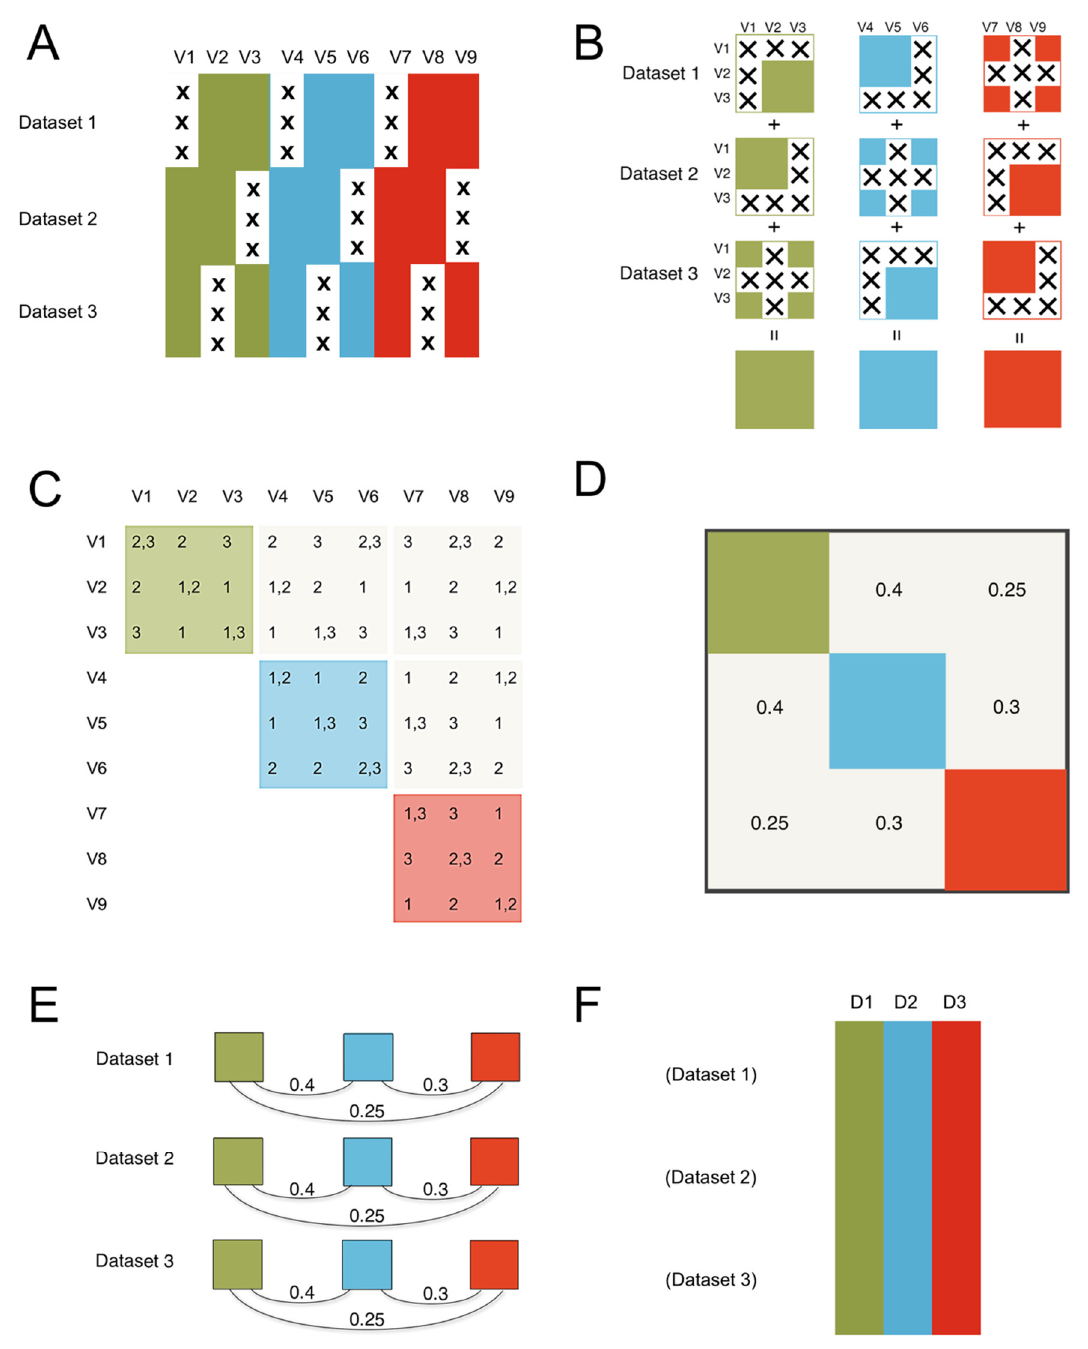
Figure 1. The ROSETTA flow of information. The method consists of three steps to get from the constituent datasets that are the input to ROSETTA in this example, to the final harmonized single output dataset. ( A ) The constituent datasets are concatenated and missing data is shown with an “X”. We assume the datasets are independent in terms of the rows; in biology, these are typically the different subjects that were measured. The columns are the nine measurements (V1-V9) that occurred across the three constituent datasets illustrated here. Importantly, no measurement was common to all three datasets, preventing a simple joint analysis on at least that one common measure, but the lack of complete overlap for any single measurement will not preclude using the Rosetta pipeline. We also applied color to show that the nine measurements come from three unique measurement domains. In the simulation study, we manipulate the strength of the correlations between the